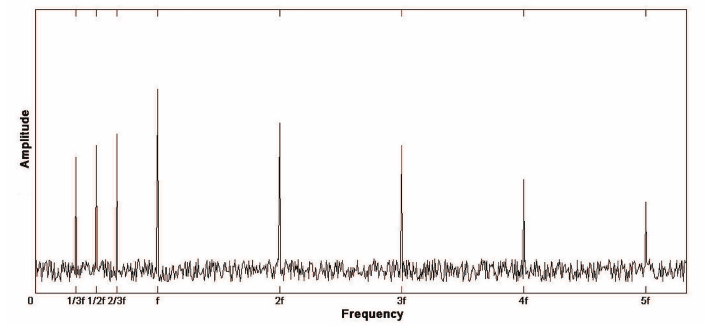
Figure 4. Spectrum diagram of loose mounting of bearing